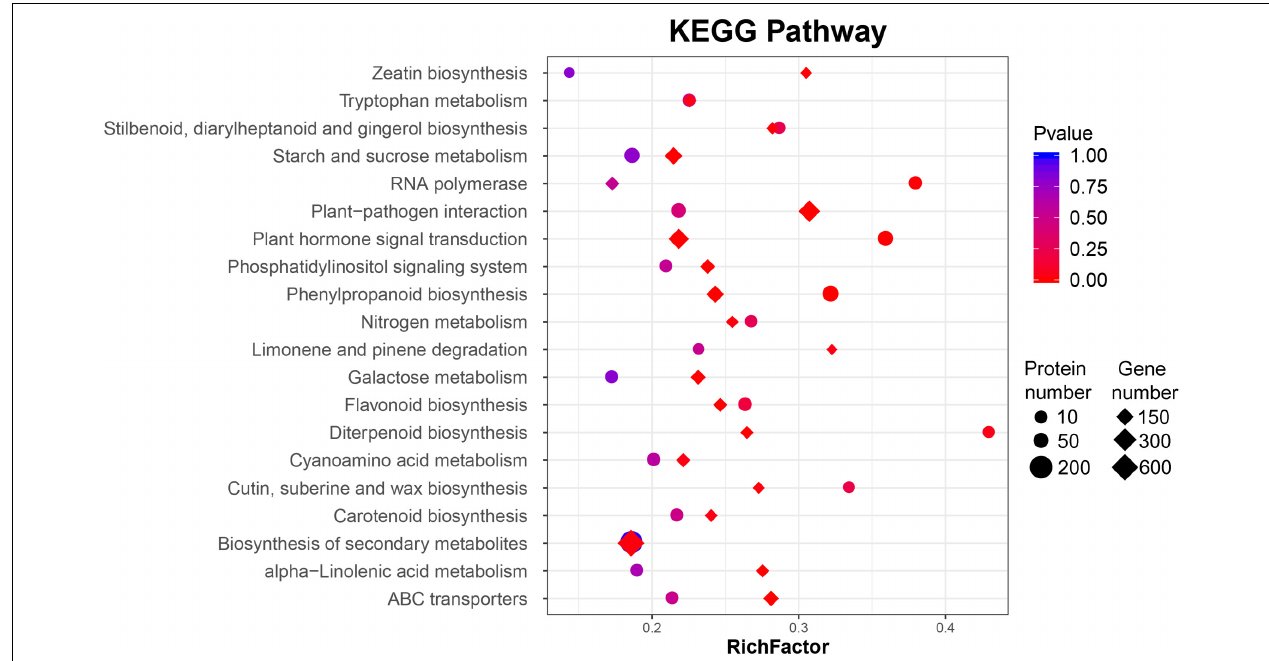
FIGURE 2 | Bubble diagrams of the KEGG enrichment of differentially expressed genes (DEGs) and proteins (DAPs) of ‘Jinkui’ leaves at 1 dpi of Psa